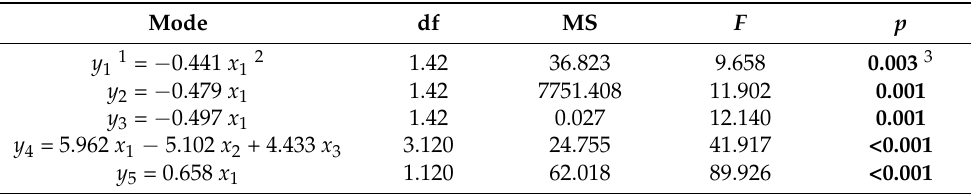
Table 3. Stepwise multiple regression with Plutella xylostella traits as the dependent variable and temperature factors as independent variables.